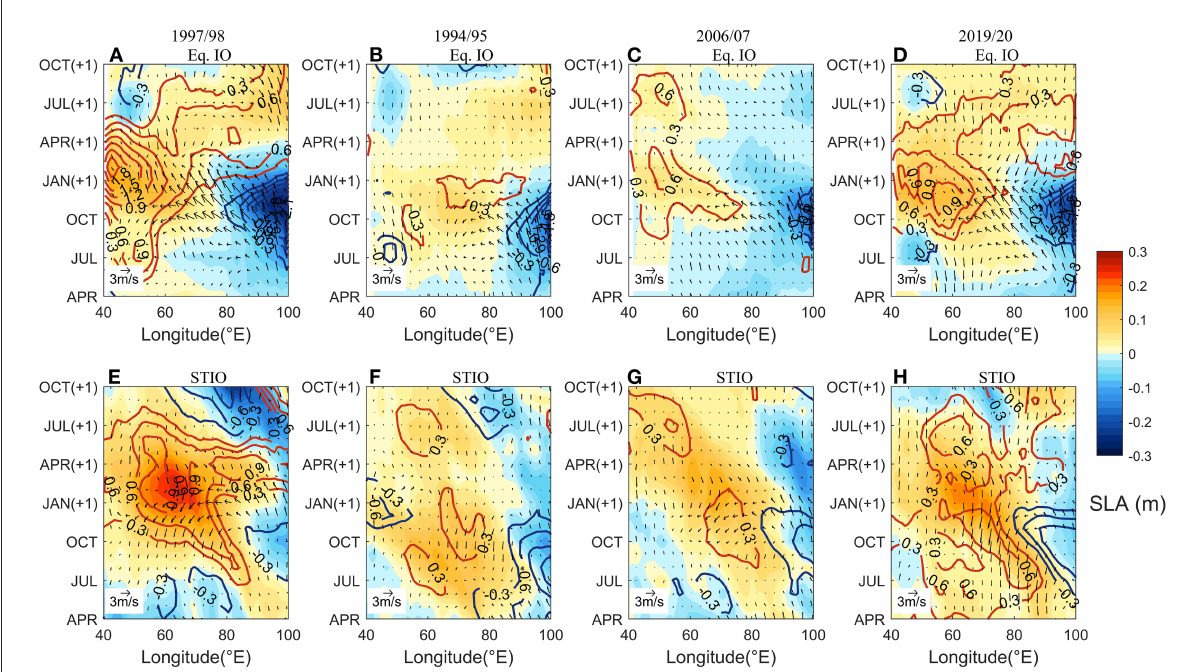
FIGURE8 Longitude-time diagram for sea level anomaly (shading, meter) and anomalous winds (vector, m/s) and SST anomaly (contour, ◦ C) along the equator [ (A–D) , Eq.IO] and 10 ◦ S [ (E,F) , STIO] in the Indian Ocean for four positive IOD events in 1997 (A,E) , 1994 (B,F) , 2006 (C,G) , and 2019 (D,H) . Data are based on OISST from 1982-2021, CCMP wind from 1988-2021, CMEMS SLA from 1993-2020. Linear trends and seasonal cycles are removed based on each period